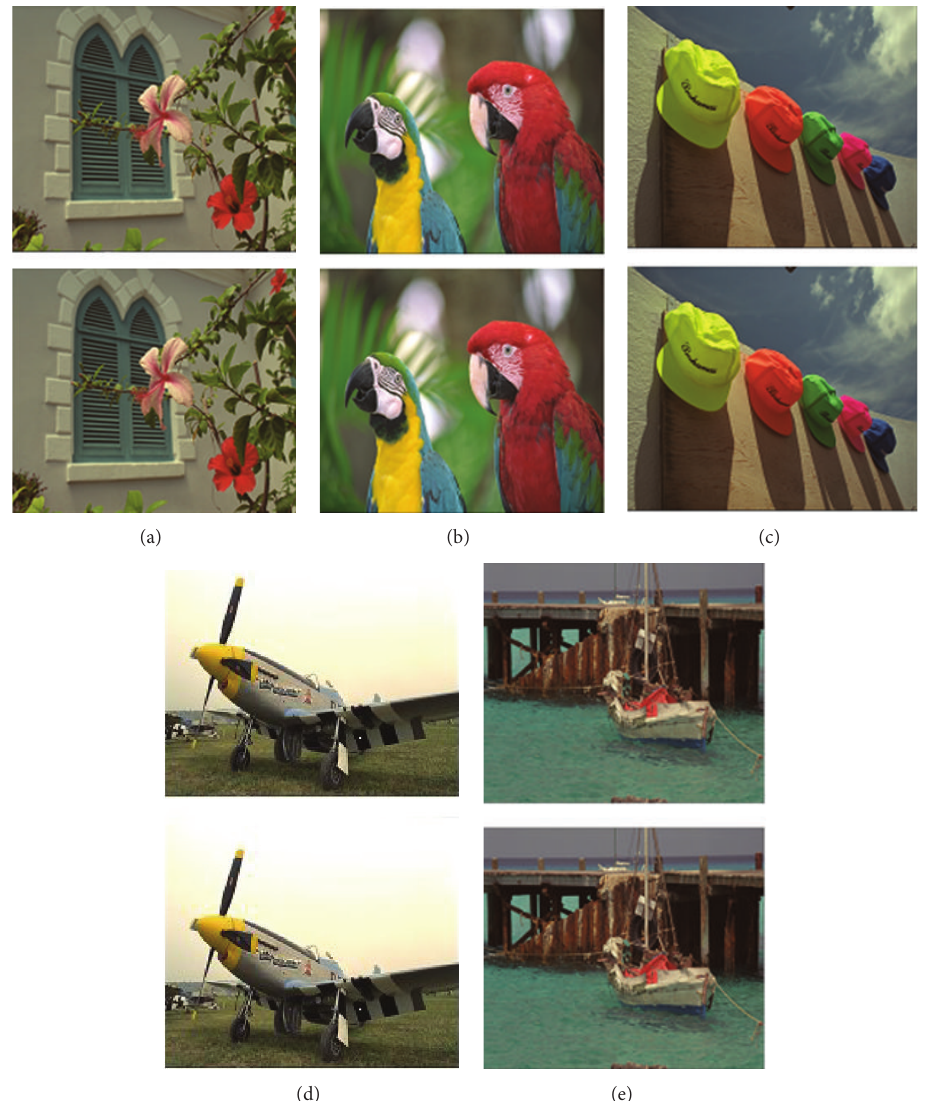
Figure 8: Comparison with JPEG 2000 with QP = 75. (a) Kodim07 (32.8% removal); (b) kodim23 (53% removal); (c) kodim03 (42.8% removal); (d) kodim20 (54.2% removal); (e) kodim11 (35% removal). The first row shows the restored images by proposed algorithm and the second row shows the restored images by JPEG